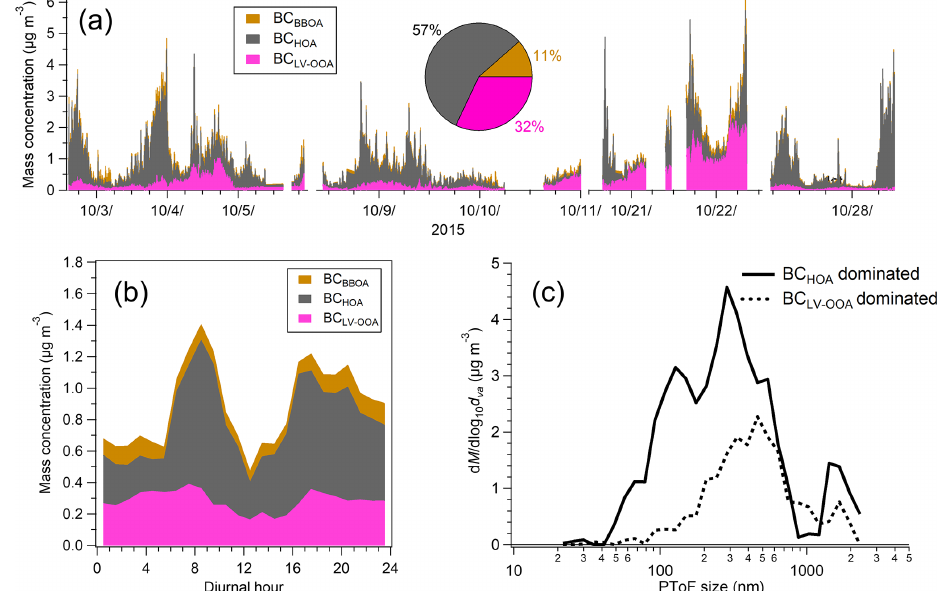
Figure 5. Source apportionment of BC by using PMF and size distributions for the SP-AMS data in the street canyon. Time series with average contributions (a) and diurnal variations (b) in the BC fractions and the size distributions when BC HOA and OOA fractions dominated (3 October 2015, 18:30 to 23:55LT and 21 October 2015, 20:00LT to 22 October 2015, 04:00LT, respectively). Time series in (a) are presented with 5min time